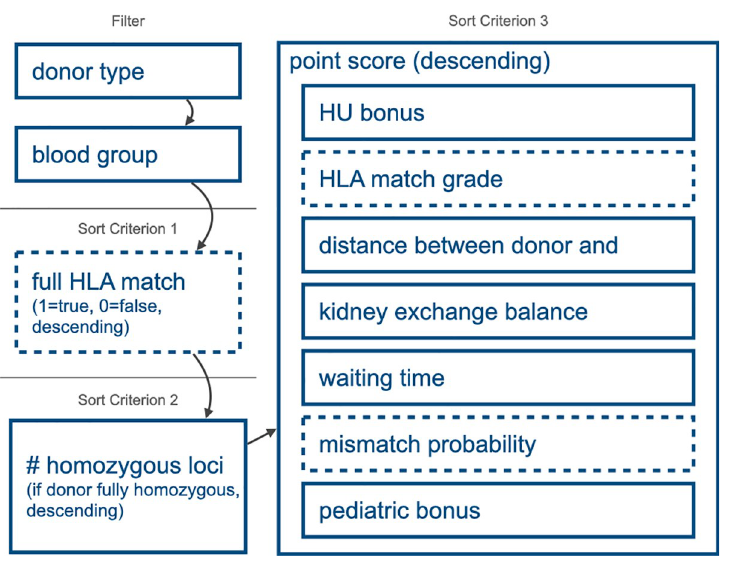
Fig 2. ETKAS algorithm. The basic ETKAS allocation consists of filtering steps and a cascade of sorting criteria. The dashed boxes refer to components involving HLA compatibility. These components were part of the altered allocation simulations. Other factors were